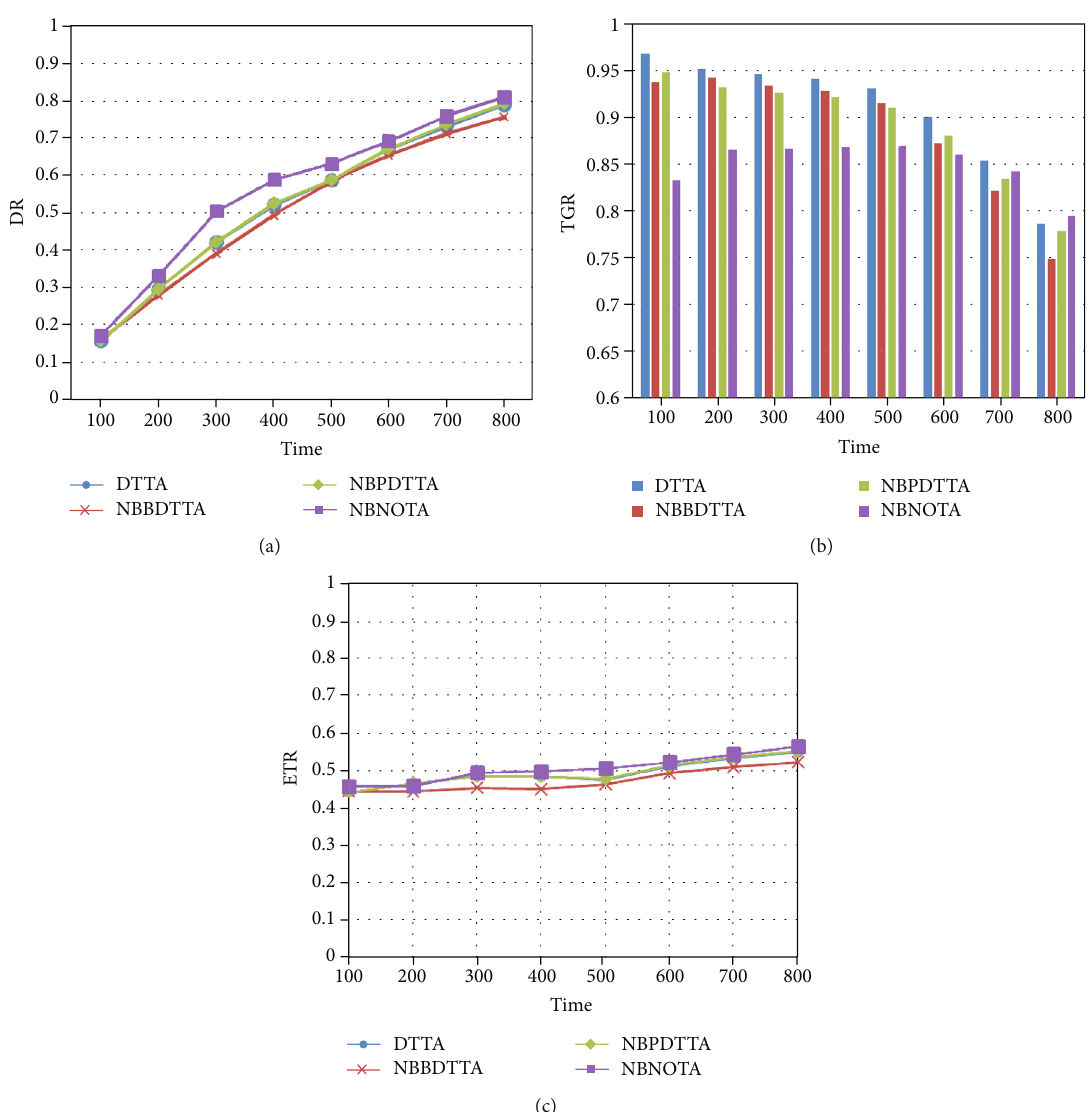
Figure 9: Performance impact of